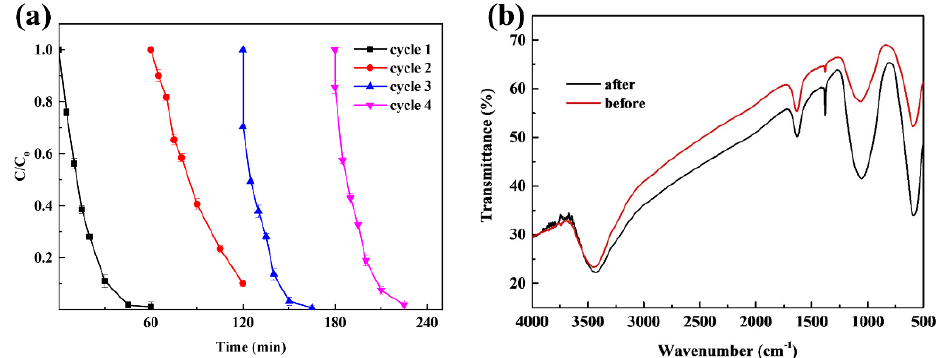
Figure 8. ( a ) Reusability of CuFe 2 O 4 (PAA = 80 mg/L, CuFe 2 O 4 = 100 mg/L, pH = 7, C 0 = 20